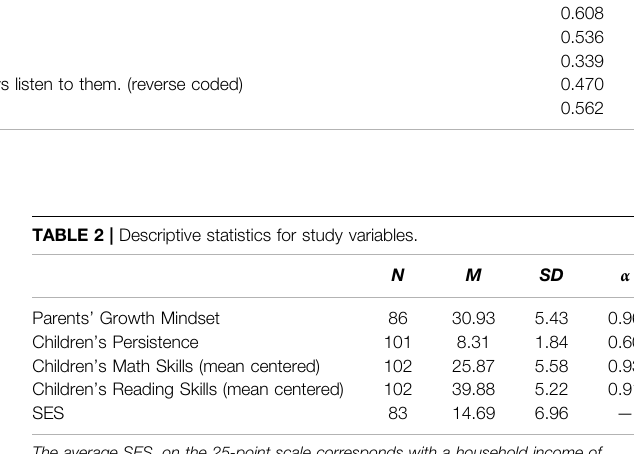
The average SES, on the 25-point scale corresponds with a household income of 73,450.